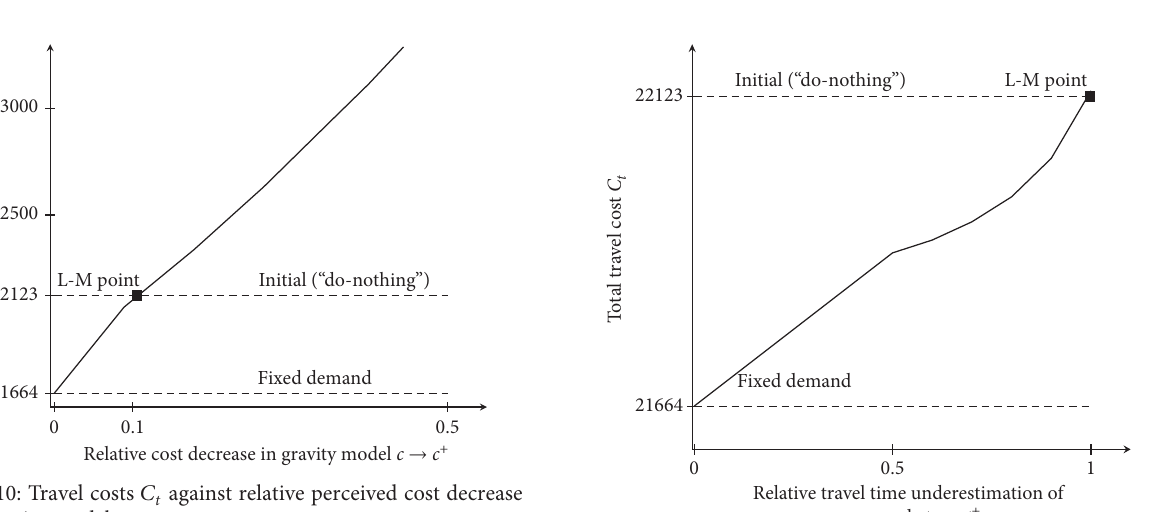
t against relative perceived utility increase ⟶ U . car car +